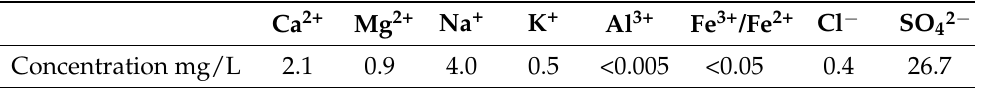
Table 2. Ionic concentration of the tap